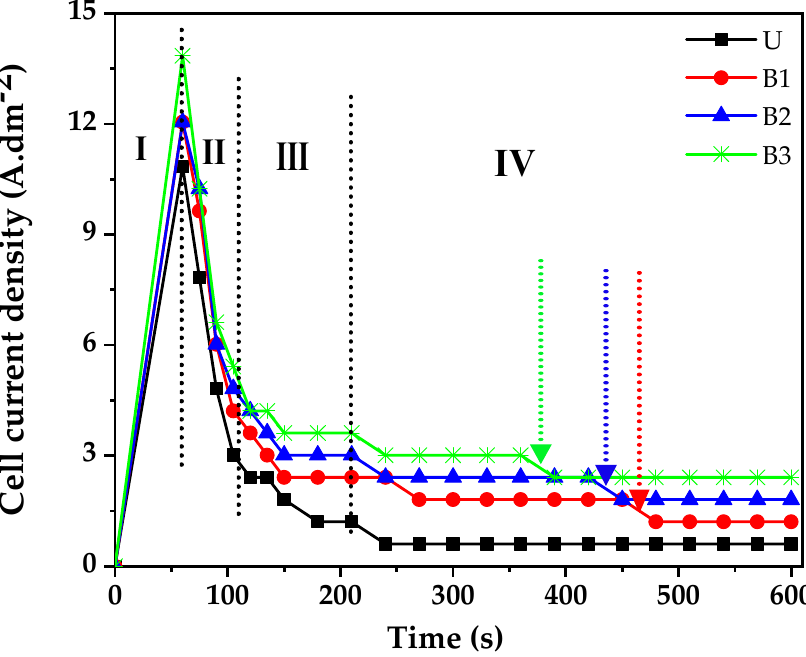
Figure 2. Cell current density versus time responses during plasma electrolytic oxidation (PEO) treatments using the waveforms described in Table 1.